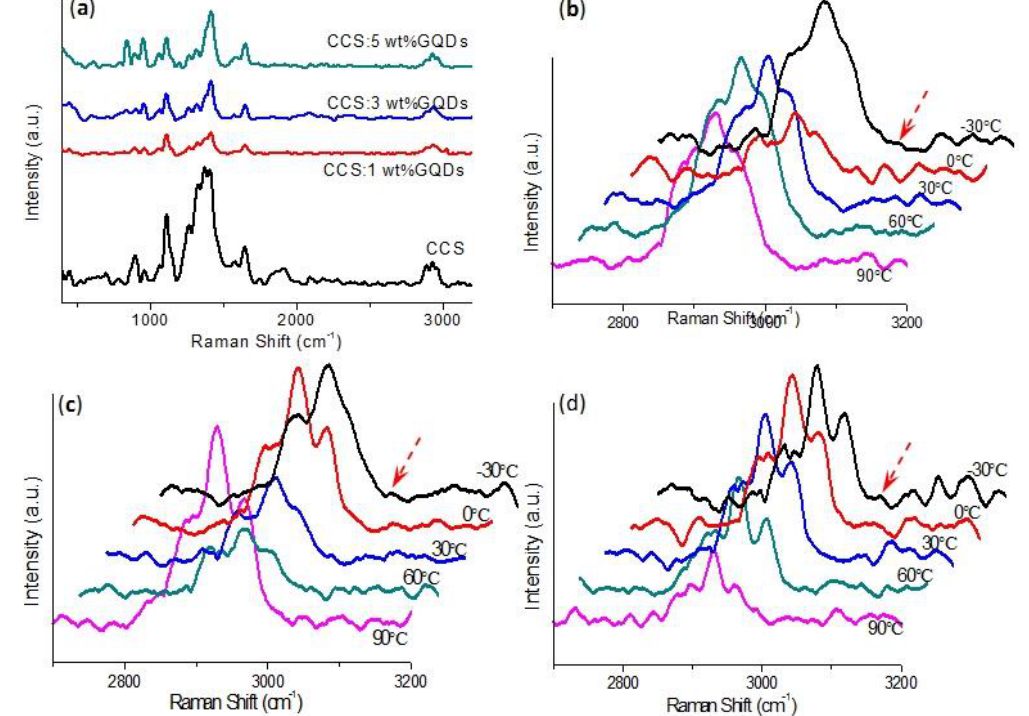
Figure 3. ( a ) Raman spectra of CCS and its nanocomposites with distinct chemical ratios of GQDs at 25 °C. Temperature dependence of Raman spectra for CCS:GQDs nanocomposites with GQD contents of ( b ) 1 wt%, ( c ) 3 wt% and ( d ) 5 wt%.